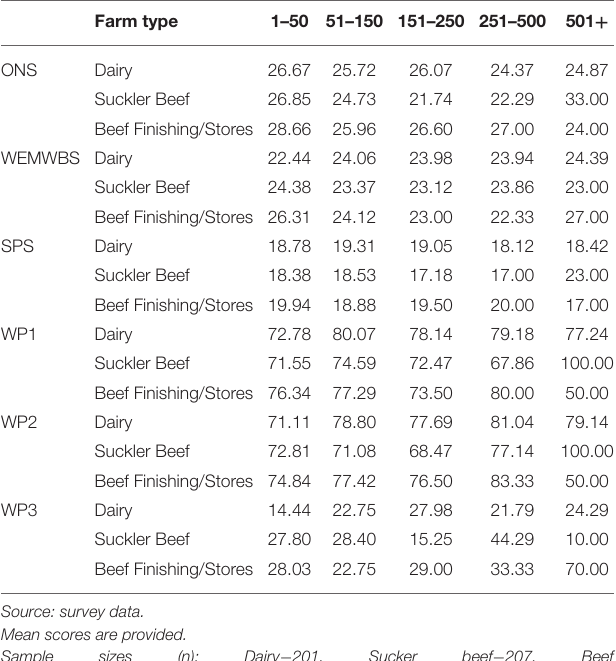
TABLE 6 | Analysis of farmer well-being and work productivity mean scores by herd size and main farm type. Farm